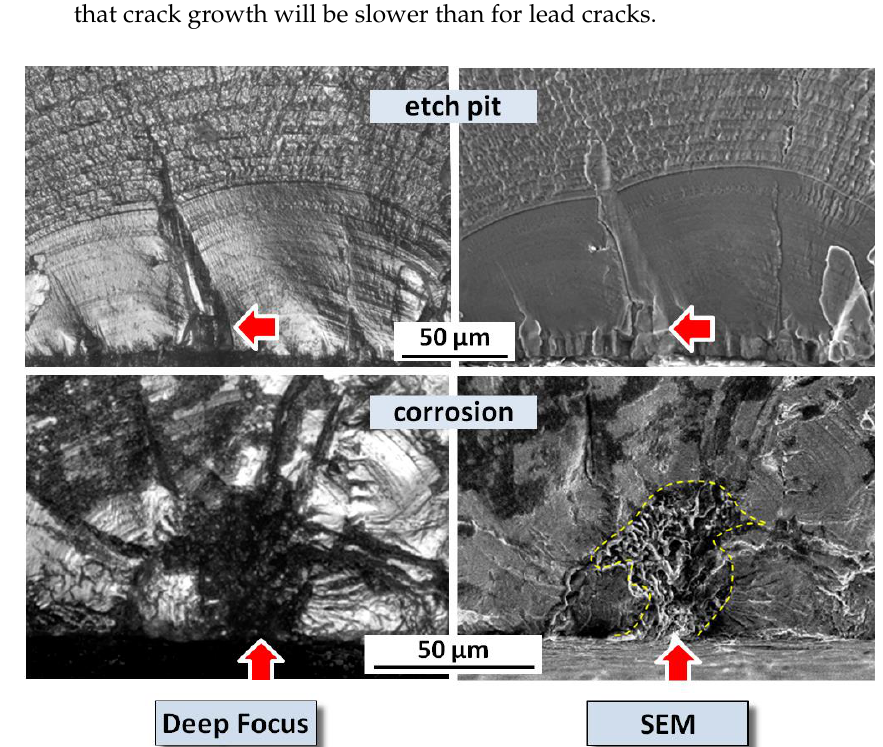
Figure 9. Optical (deep focus) and SEM fractographs of fatigue cracking nucleating from a large etch pit and a corrosion pit on AA 7050-T7451 plate surfaces, from [34].